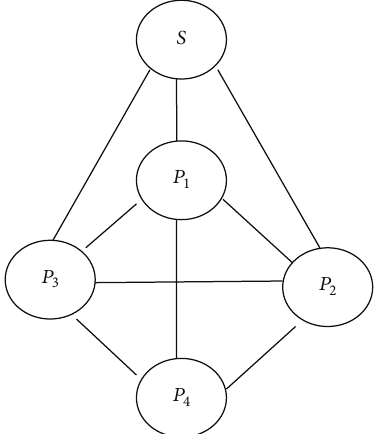
Figure 1: The source 𝑆 distributes packets to the peers 𝑃 1 , 𝑃 2 , 𝑃 3 , and 𝑃 4 over overlay network.